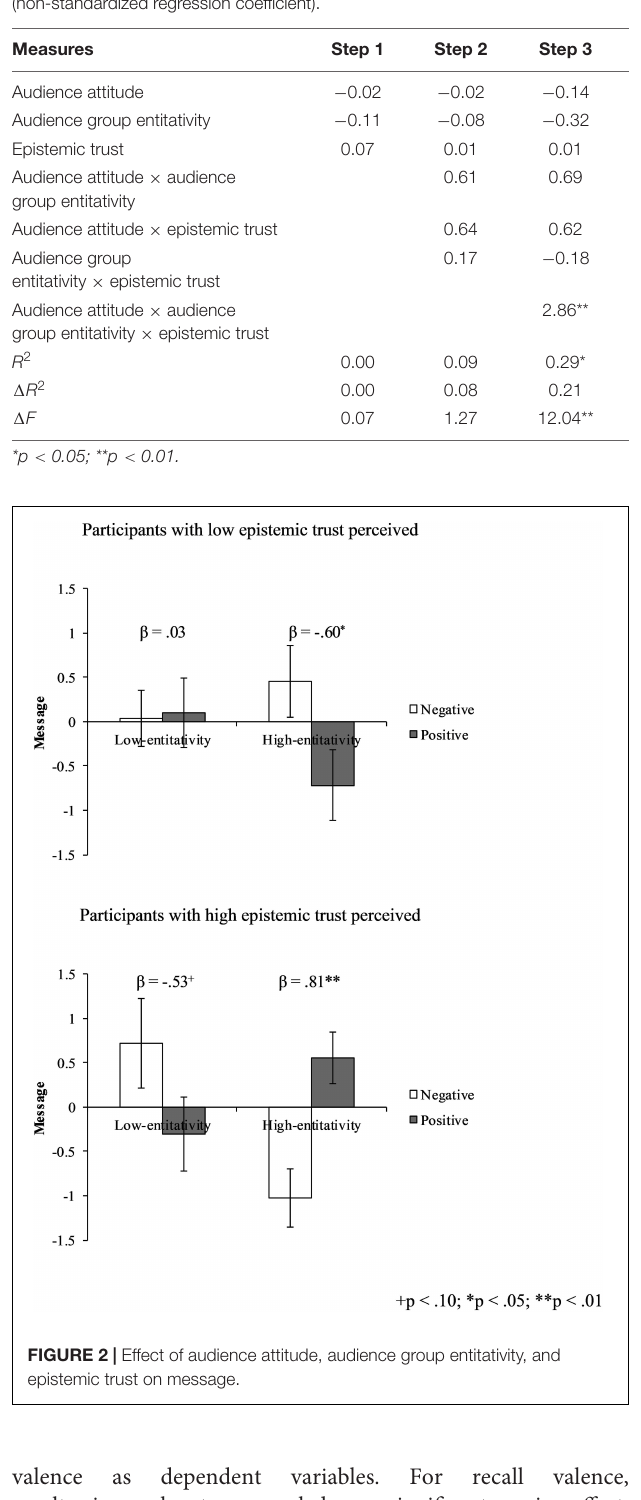
TABLE 1 | Moderated multiple regression analysis with message valence as a function of audience attitude, audience group entitativity, and epistemic trust (non-standardized regression coefficient).